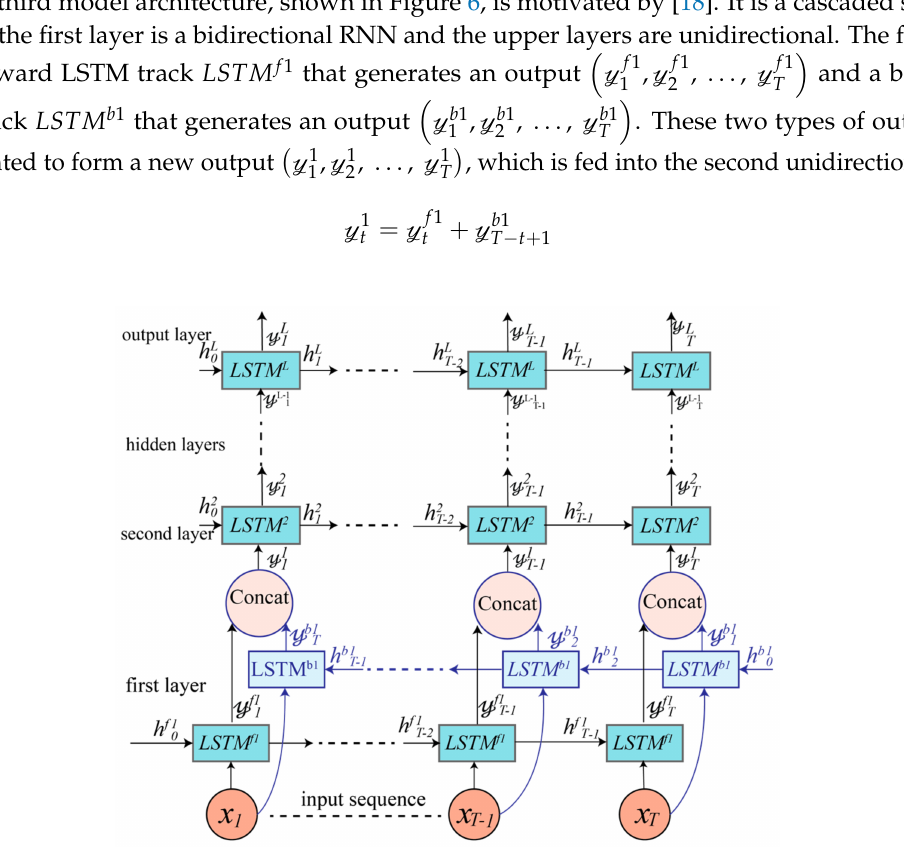
Figure 6. Cascaded unidirectional and bidirectional LSTM-based DRNN model. The first layer is bidirectional, whereas the upper layers are unidirectional. The number of hidden unidirectional layers is a hyperparameter that is tuned during